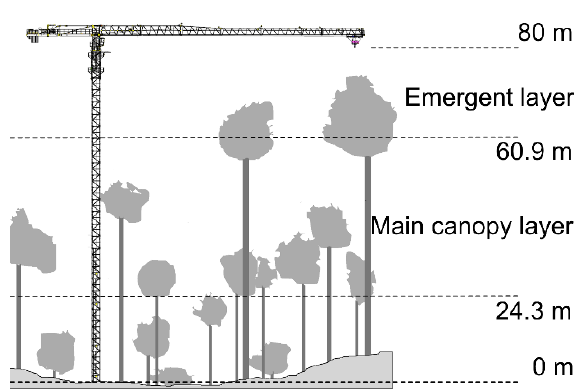
Figure 1. Vertical profile of the Xishuangbanna tropical seasonal rainforest with the canopy crane.